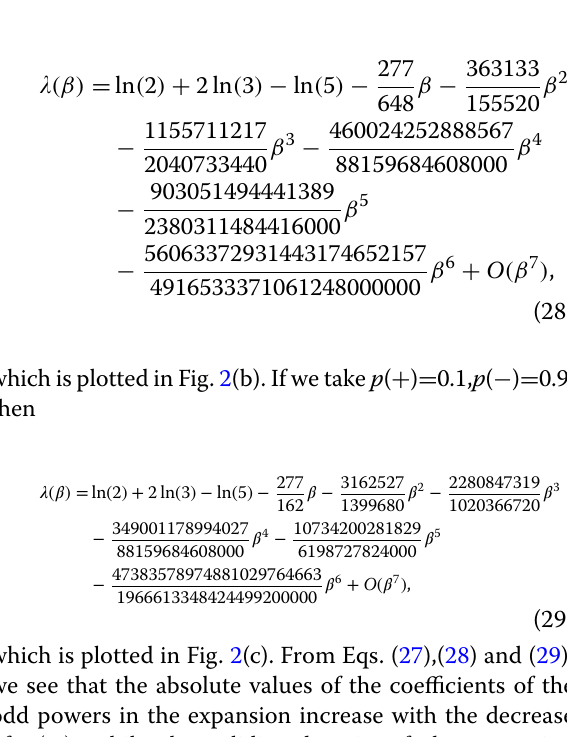
Fig. 2 (Color online) The dependence of the MLE on β . For Eq. (26) with (a) p ( the system given by Eq. (30) with p ( with (red) solid